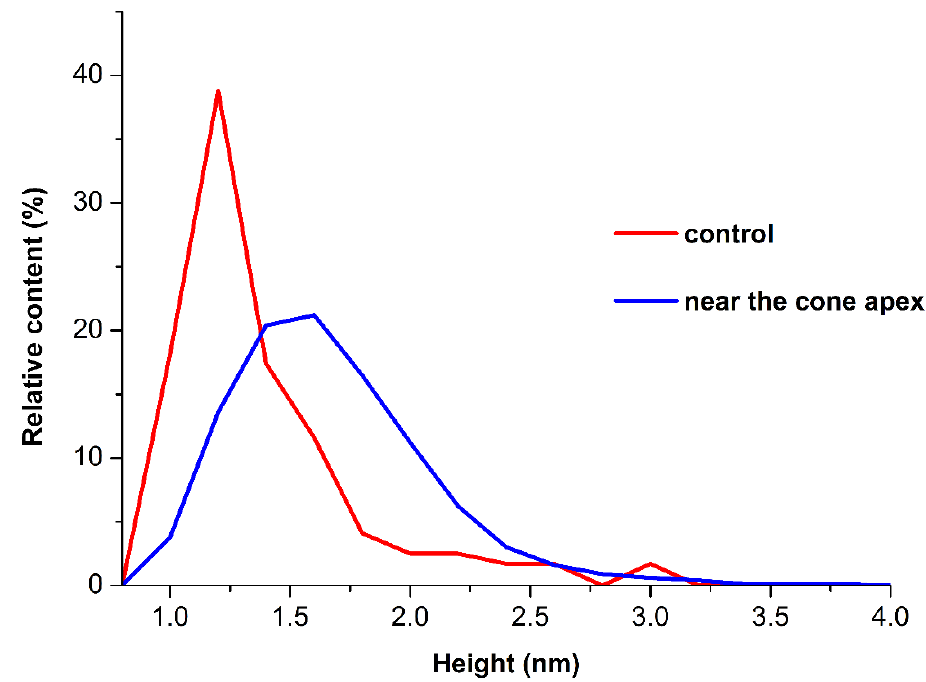
Figure 3. Plots of ρ (h) distributions for the HRP samples incubated either near the cone apex (at L = 2 cm, working experiment; blue curve) or far away from the cone (at L > 10 m, control experiment; red curve).